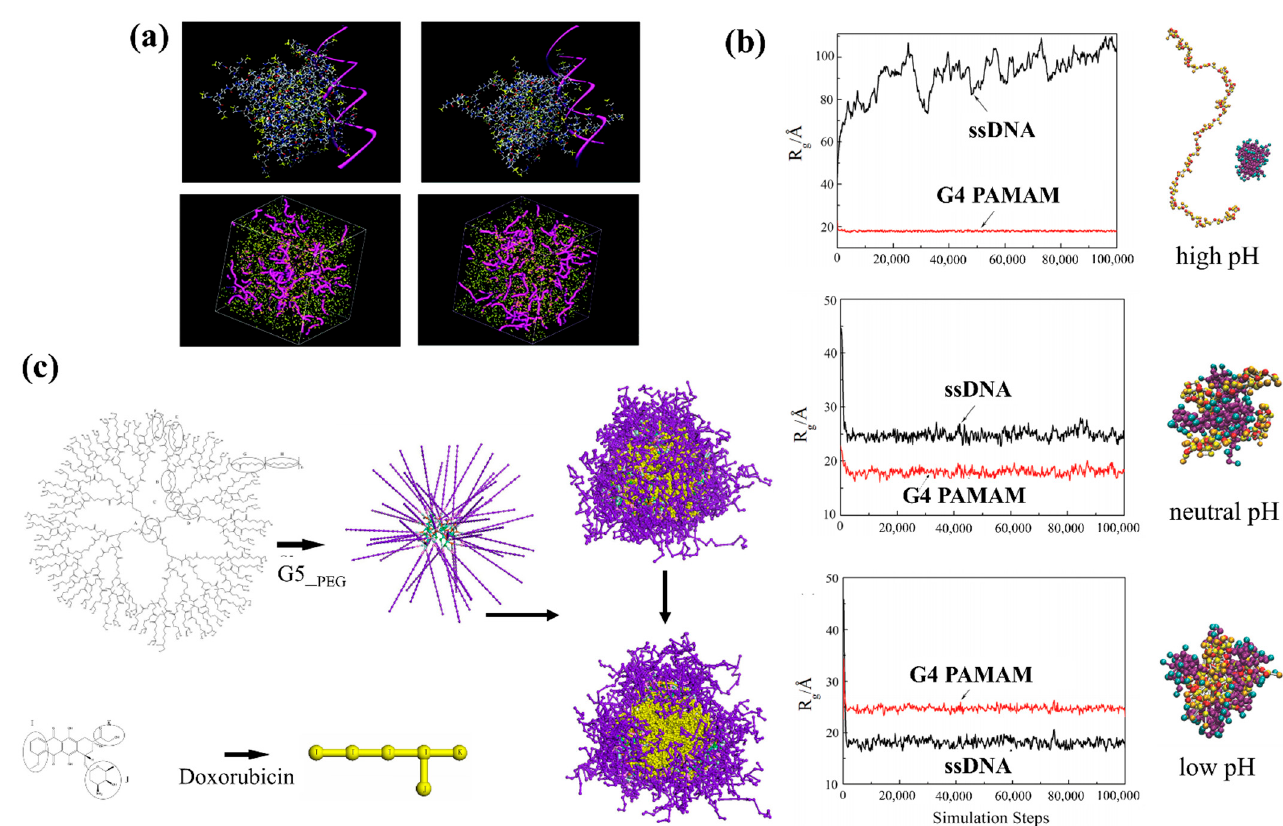
Figure 2. ( a ) Triethanolamine (TEA)-core dendrimer ( top left ), NH 3 -core dendrimer ( top right ) in complex with a small fragment of double-helix DNA (highlighted as a magenta ribbon). Mesoscale morphologies of the self-assembled systems between TEA-core dendrimers and DNA ( bottom left ) and NH 3 -core and DNA ( bottom right ) [143]. ( b ) Evolution of the radius of gyration (R g ) of ssDNA and G4 PAMAM dendrimer at various pH values [144]. ( c ) Chemical structures of dendrimer and drug molecules in DPD simulation ( left ), their corresponding simplified beads in the coarse-gained models ( middle ), and the computed G5-PEG/DOX microspheres ( right ) [147].